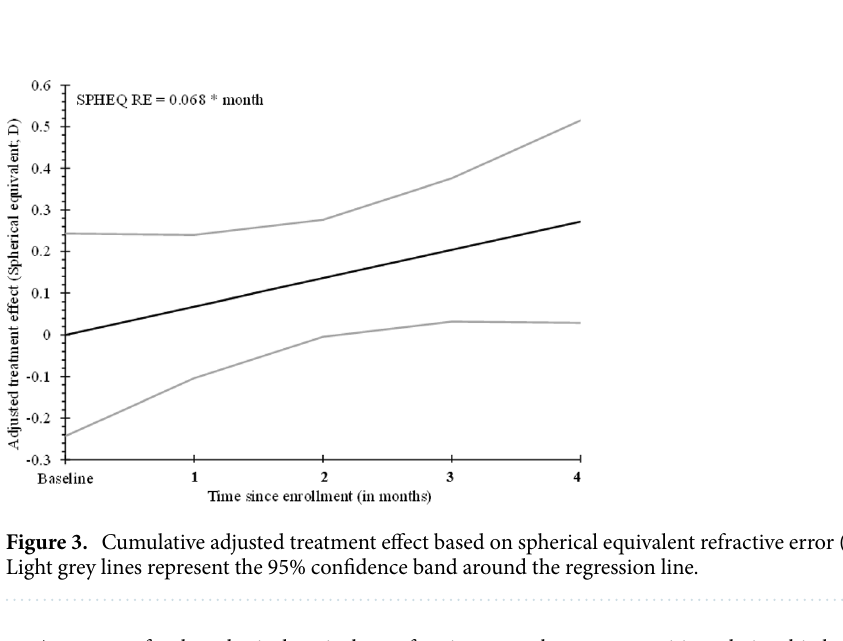
Table 1. Demographic characteristics and pre-treatment cycloplegic refraction using ANWAR optical apparatus and axial length for enrolled subjects (n = 7).